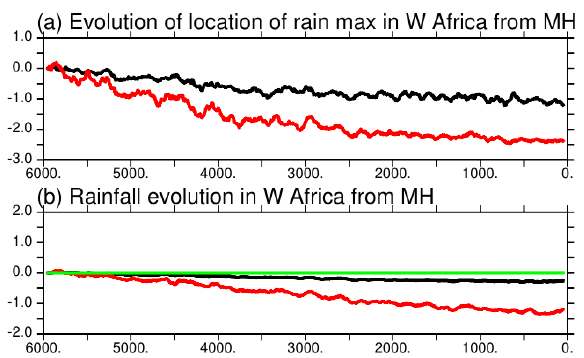
Figure 12. Evolution of (a) the location of the West African mon- soon annual mean (black) and maximum (red) rain belt in degrees of latitude and (b) annual mean (black), minimum (green), and maxi- mum (red) monthly precipitation (mmd − 1 ) averages over the Sahel region. The first 100 years have been removed and a 100-year run- ning mean applied before